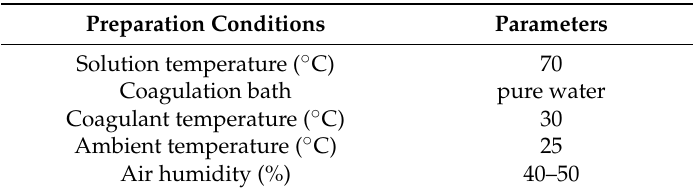
Table 1. Preparation conditions of PPSU membranes.